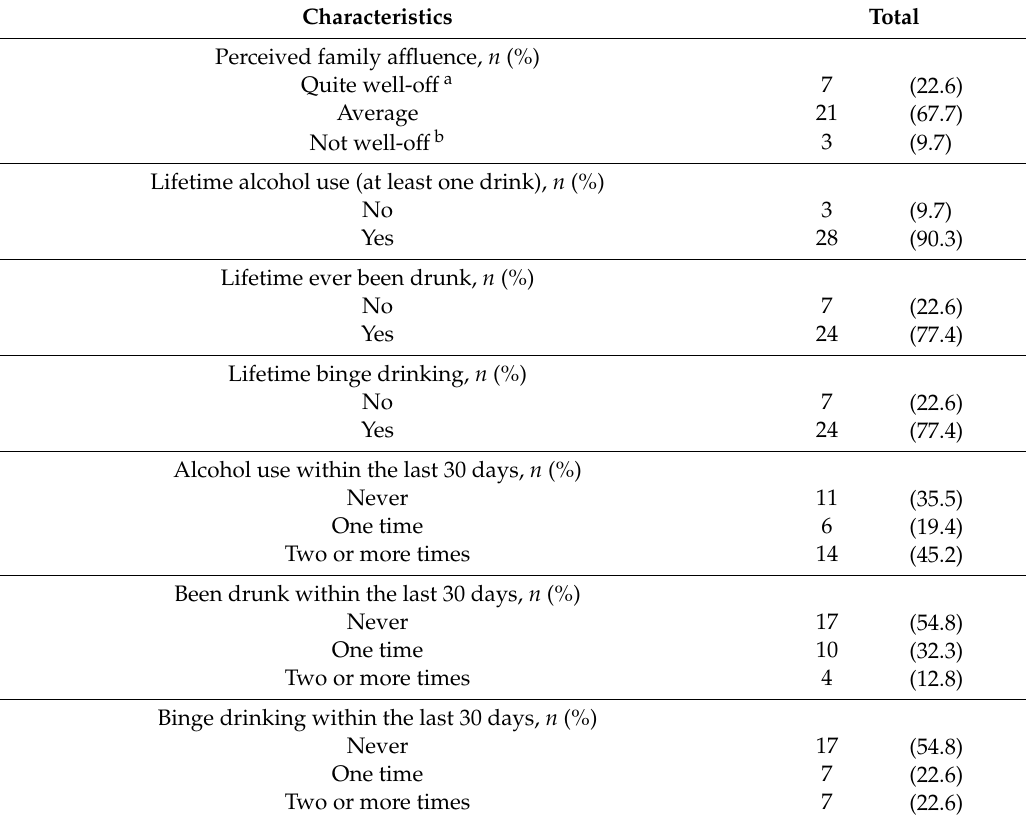
Table 1. Characteristics of the respondents ( n = 31).